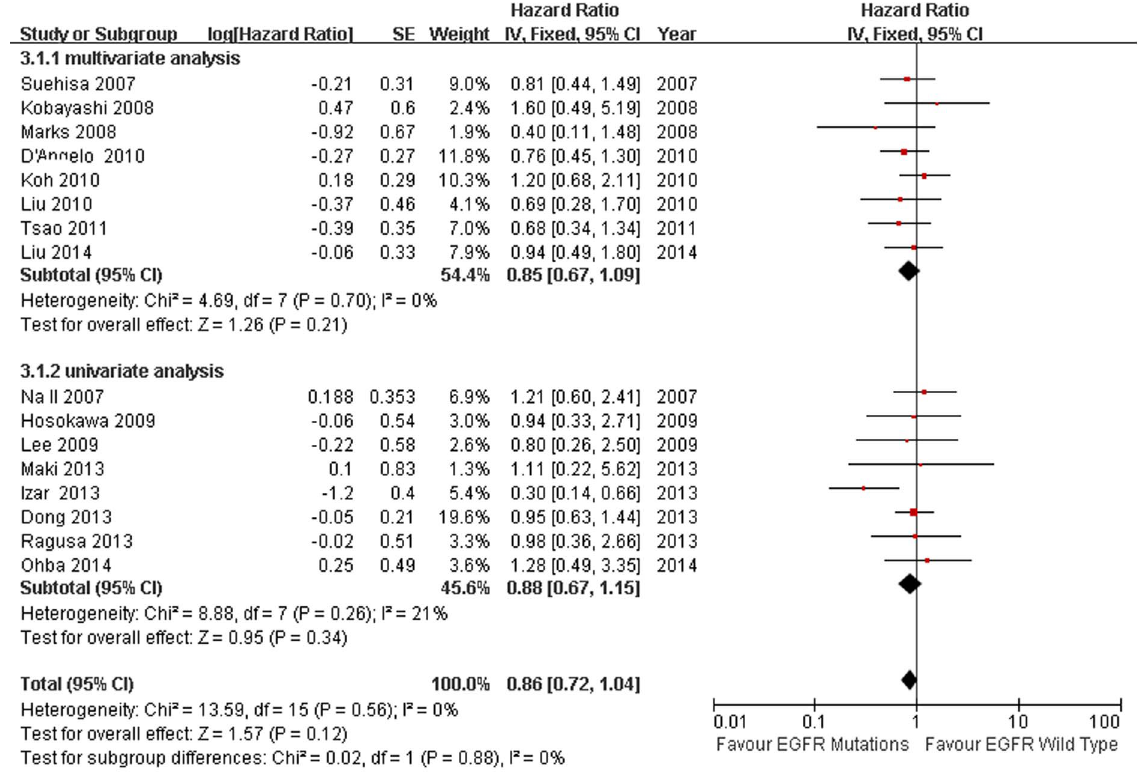
Figure 7. Fixed-effect model forest plot of HR of OS in statistical analysis method subgroup analysis according to EGFR mutation status. Solid diamond indicates the pooled HR of OS, Square indicates hazard ratio value of each study.